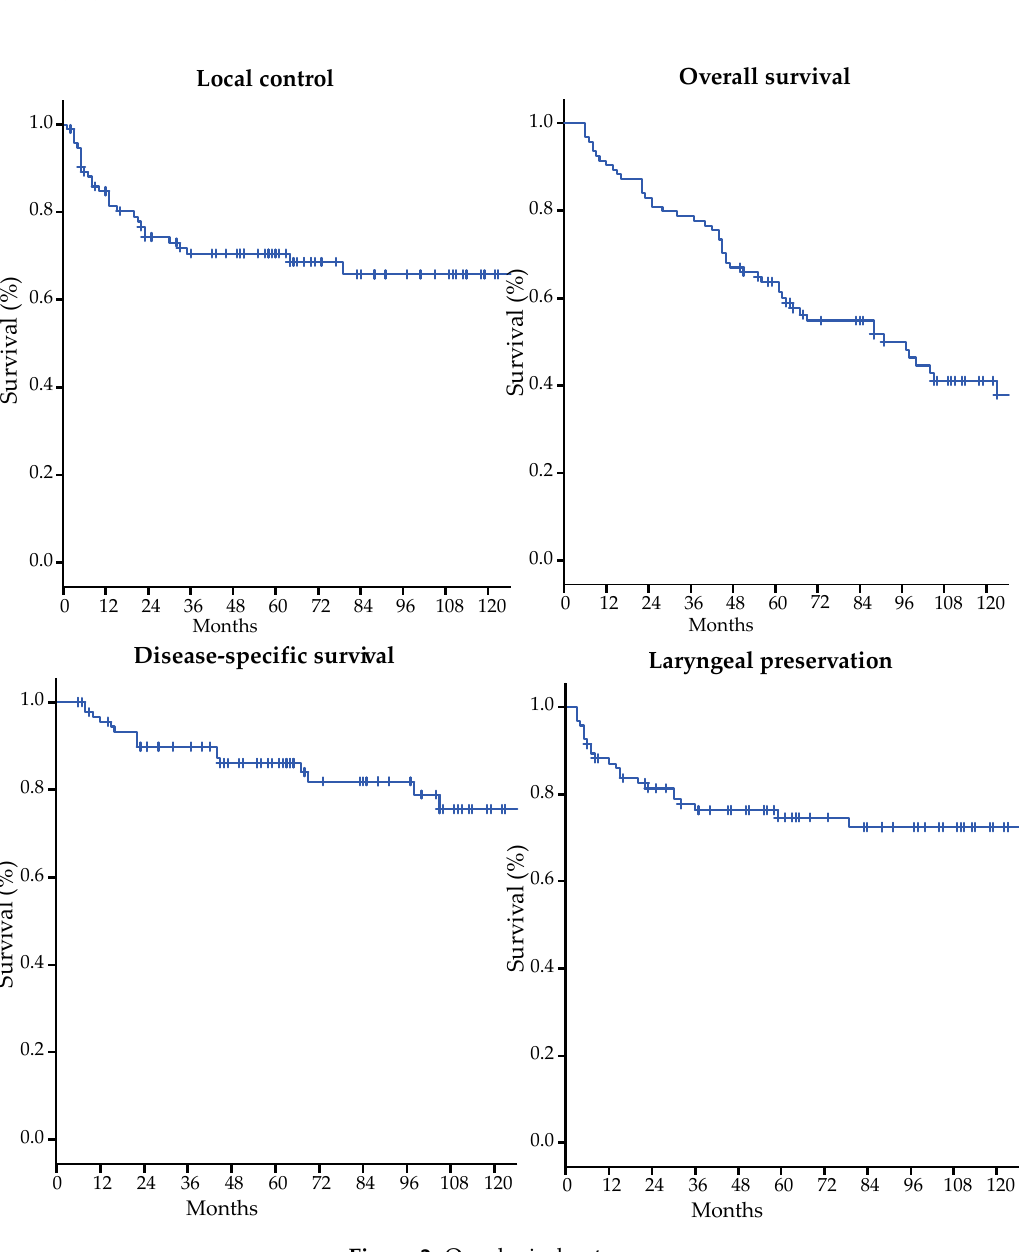
Figure 2. Oncological Figure 2 . Oncological outcomes .